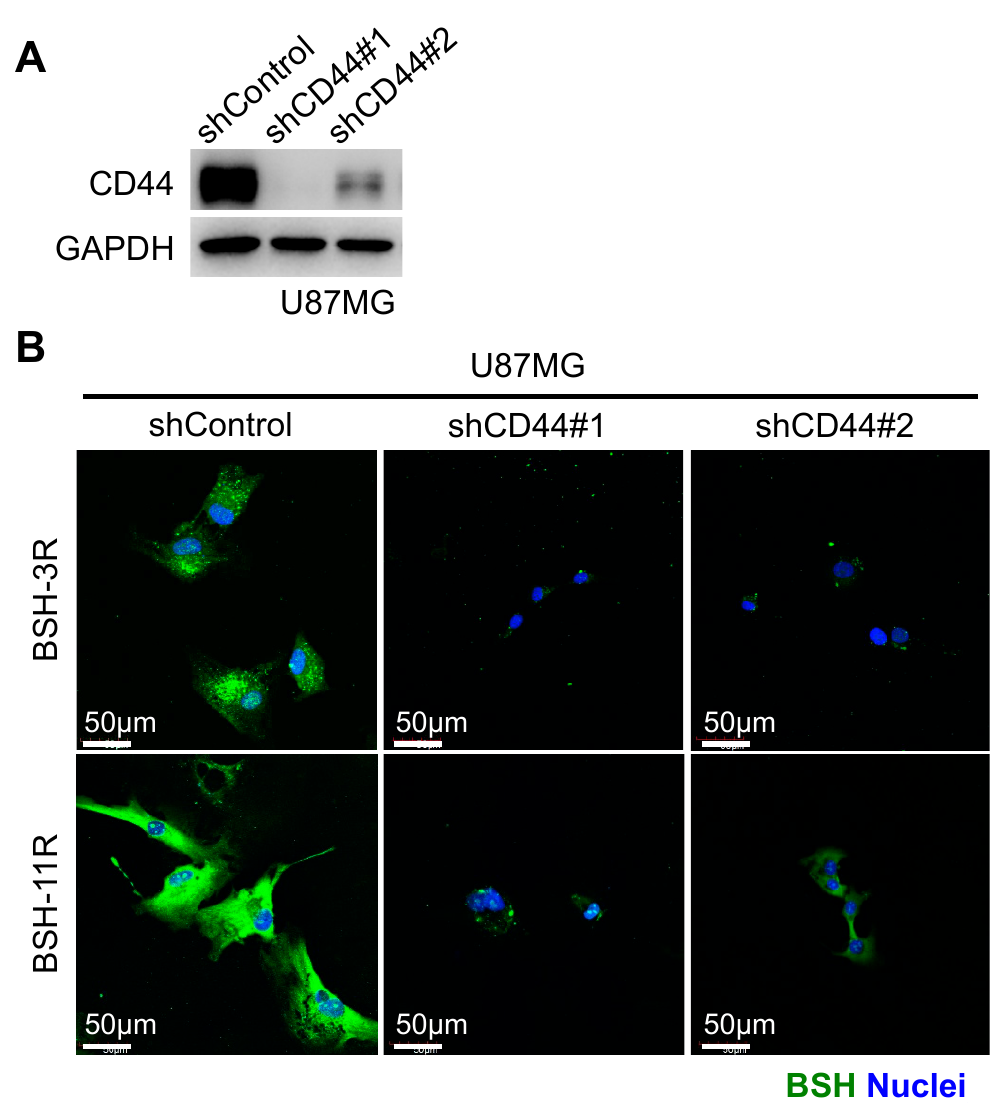
Figure 2. CD44 is required for cellular uptake of BSH-11R. ( A ) Lentivirus vectors expressing a short hairpin RNA (shRNA) against human CD44 worked and reduced the protein level of CD44 in U87MG cells. ( B ) CD44 depletion significantly reduced the cellular uptake of both BSH-3R and